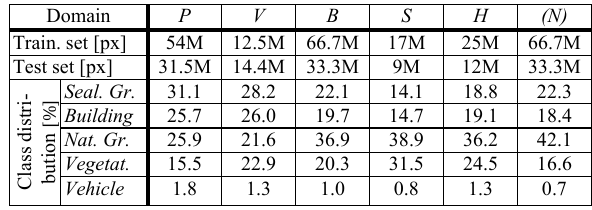
Table 1: Dataset